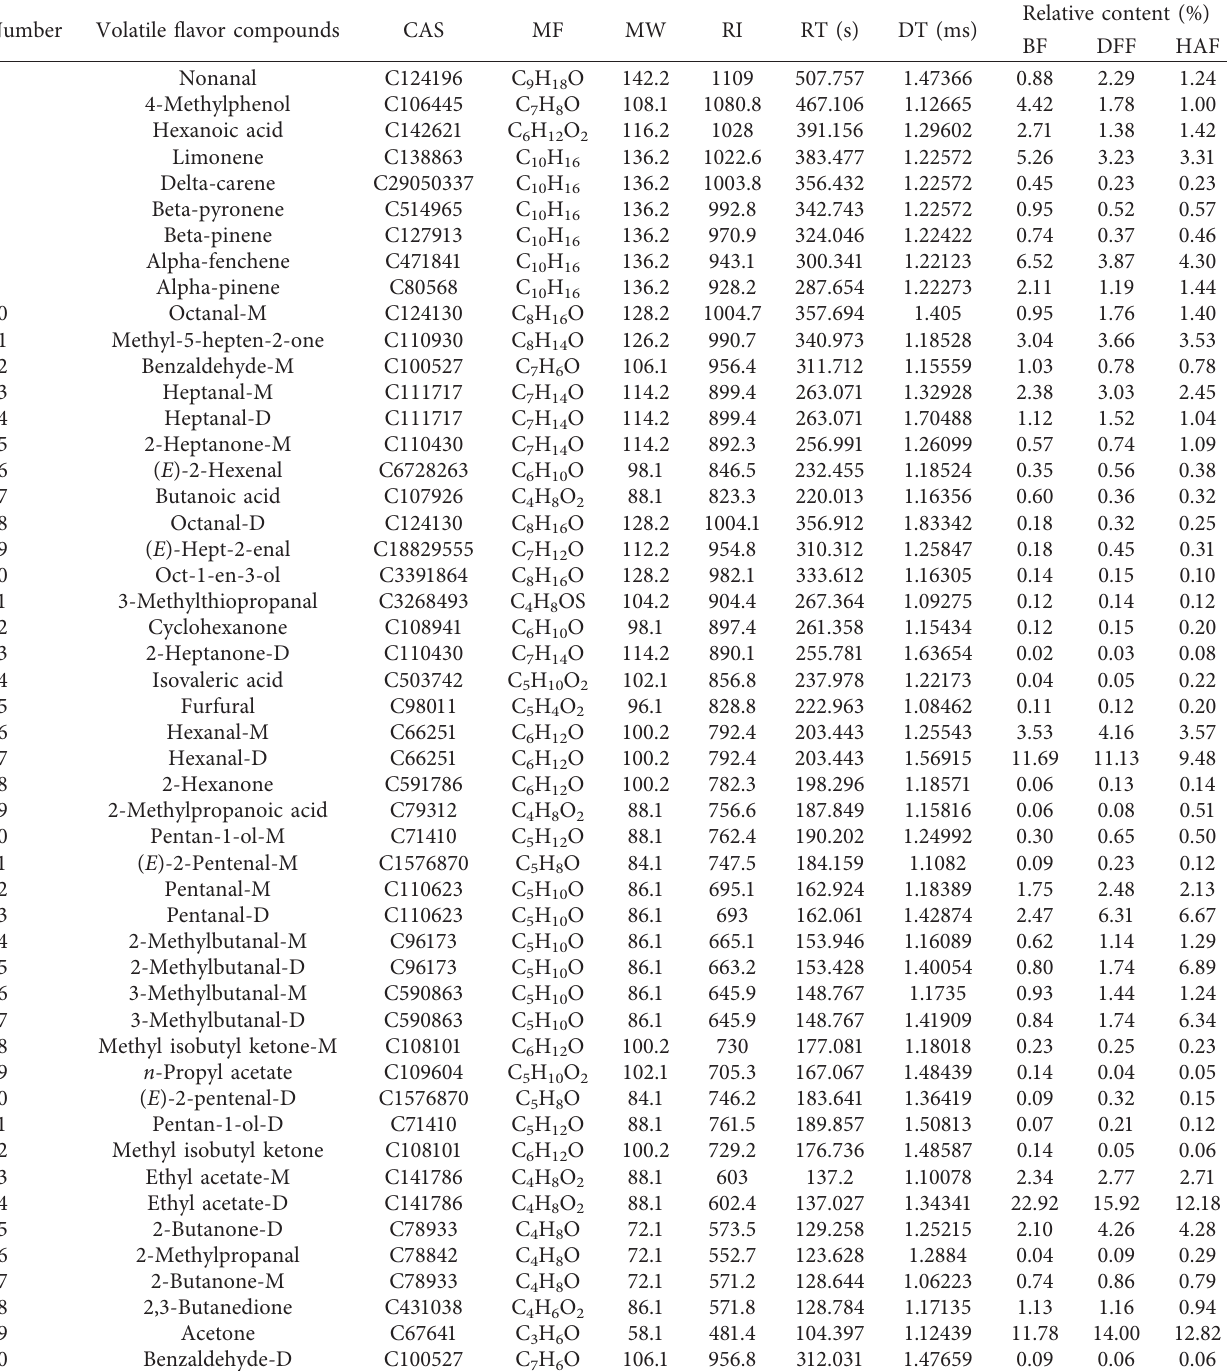
Table 2: Qualitative analysis of volatile flavor substances of giant salamander meatball before and after